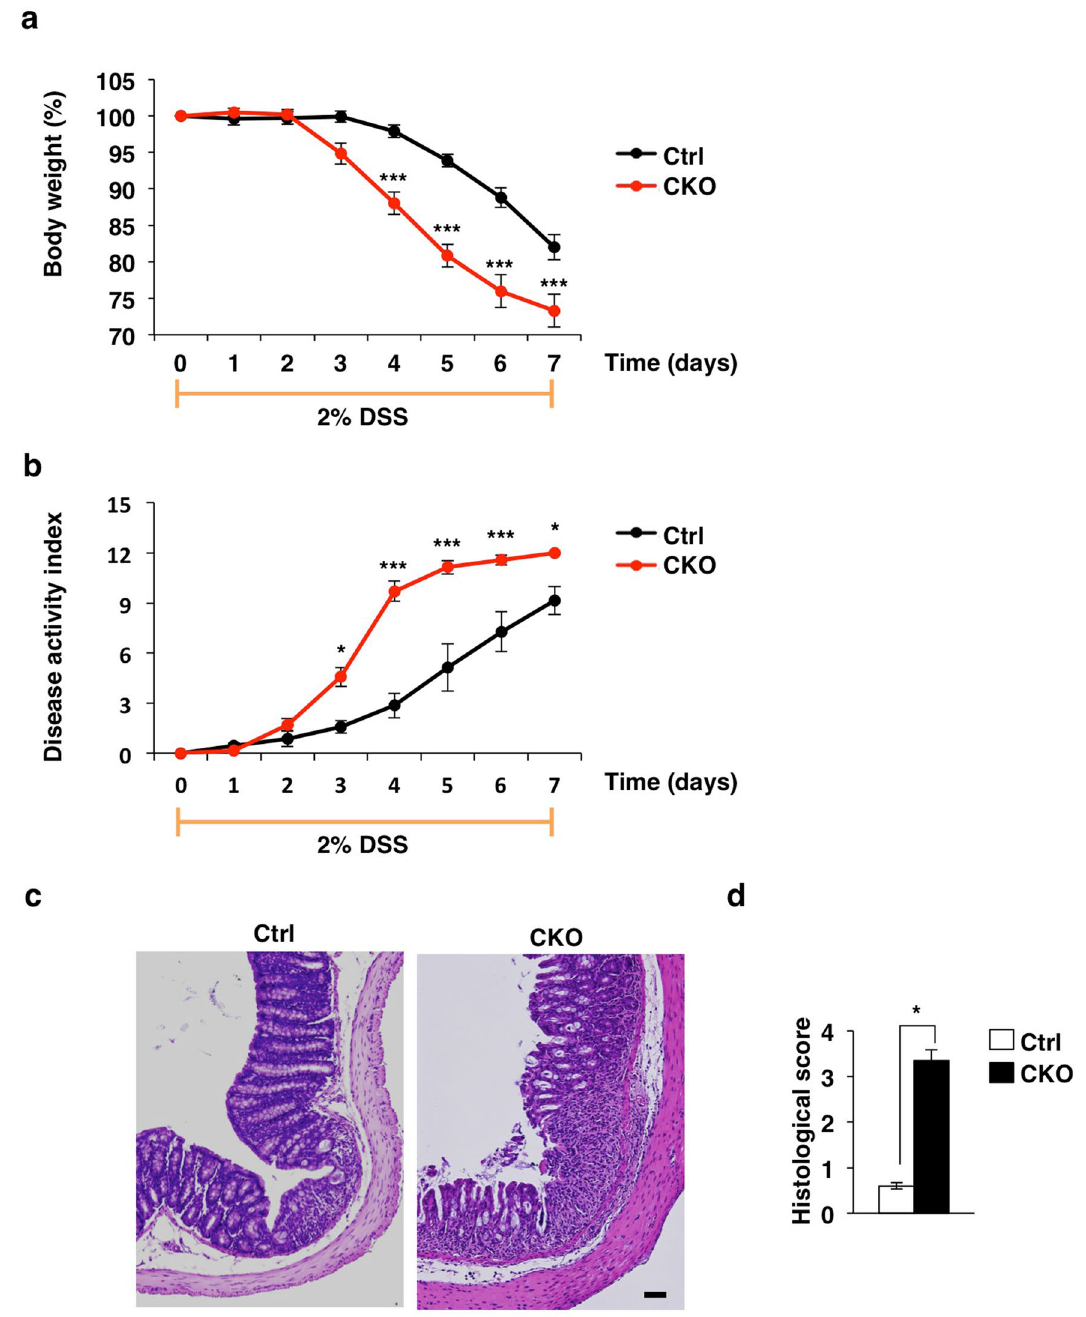
Figure 5. Increased susceptibility of Tsc2 CKO mice to DSS-induced colitis. ( a ) Body weight of 9- to 11-week-old control ( n = 6) and Tsc2 CKO ( n = 6) mice supplied with drinking water containing 2% DSS for 7 days. Data are expressed as a percentage on the initial value and are means ± s.e. *** P < 0.001 versus the corresponding value for control mice (two-way repeated ANOVA and Sidak’s test). ( b ) Disease activity index for control ( n = 6) and Tsc2 CKO ( n = 6) mice treated as in (a) . Data are means ± s.e.. * P < 0.05; *** P < 0.001 versus the corresponding value for control mice (two-way repeated ANOVA and Sidak’s test). ( c ) Representative images of hematoxylin-eosin–stained, paraffin-embedded colon sections from control and Tsc2 CKO mice at 3 days after the start of DSS treatment as in (a) . Scale bar, 100 μm. ( d ) Histological score of 9- to 11-week-old control ( n = 4) and Tsc2 CKO ( n = 4) mice determined from sections similar to those in (c) . Data are means ± s.e.. * P < 0.05 (Student’s t